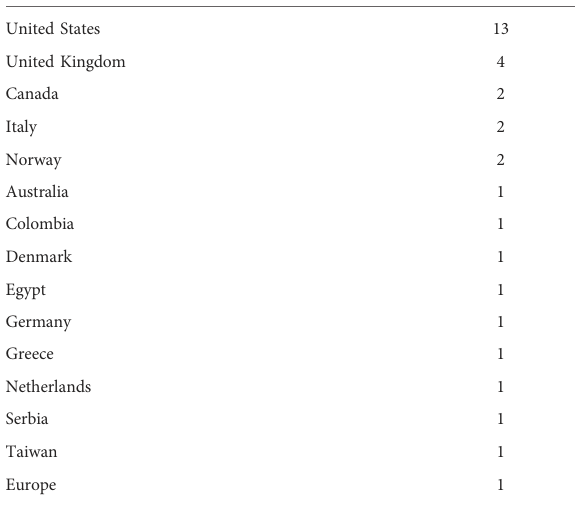
TABLE 2 Number of articles per